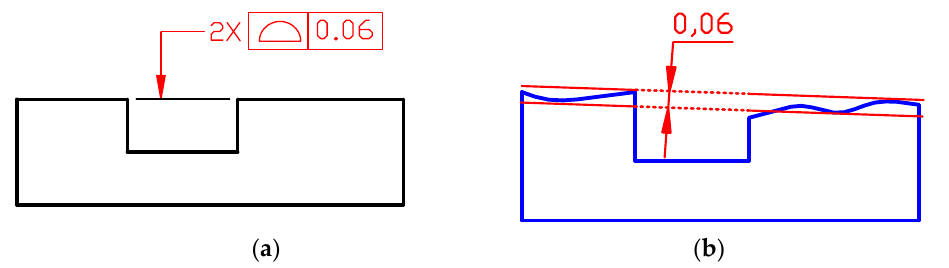
Figure 7. ( a ) Specification of surface profile tolerance for coplanar surfaces (ASME Y14.5); ( b ) each surface shall be within two parallel planes 0.06 mm apart. Two sets of parallel planes are coplanar. The right surface of the actual part is out of the tolerance zone—the requirement is not satisfied.